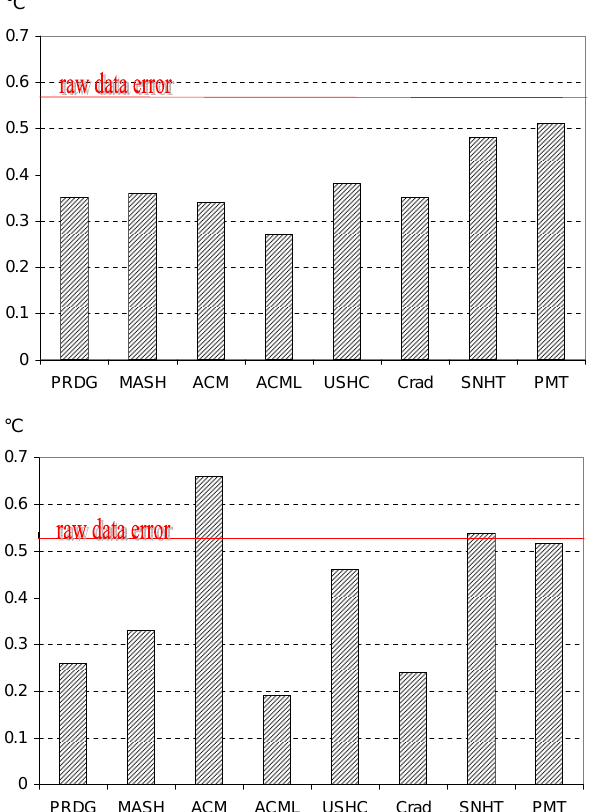
Figure 2. E ffi ciencies of monthly temperature homogenisation for selected homogenisation methods. PRDG = PRODIGE, ACM = early ACMANT, ACML = late ACMANT, USHC = USHCN, Crad = Craddock-test. (a) (upper) RMSE of monthly values. (b) (bot- tom) RMSE of biases in network-mean linear